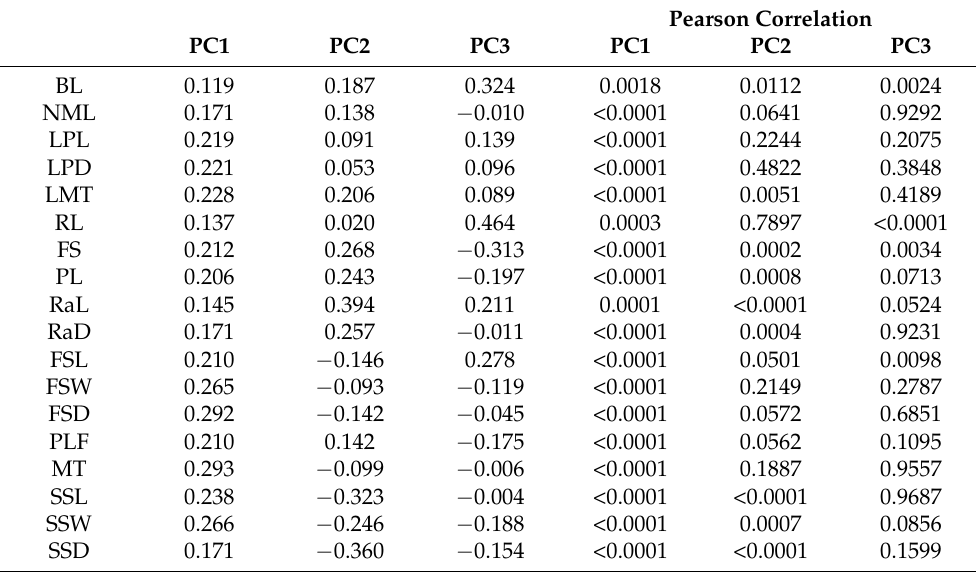
Table 2. Pearson’s correlation coefficients for the first three main components of quantitative variables in the analysis of variability of Sechium edule .